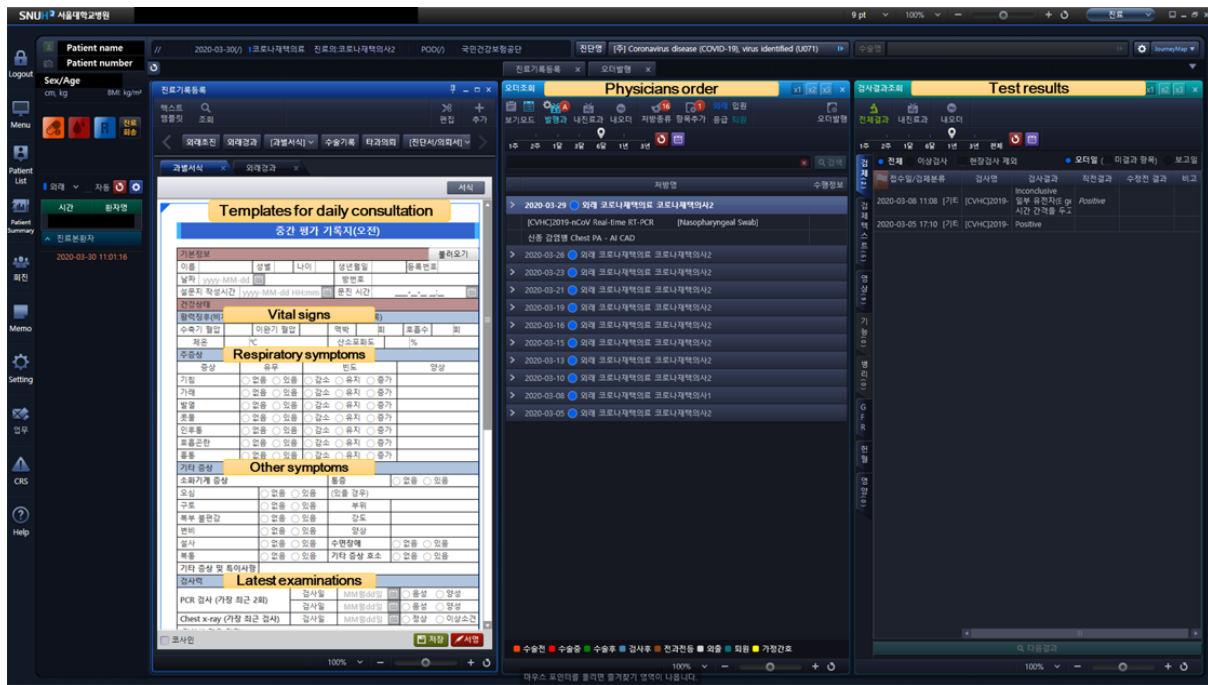
Figure 2. Modified EHR template for daily consultation at the LTSC.